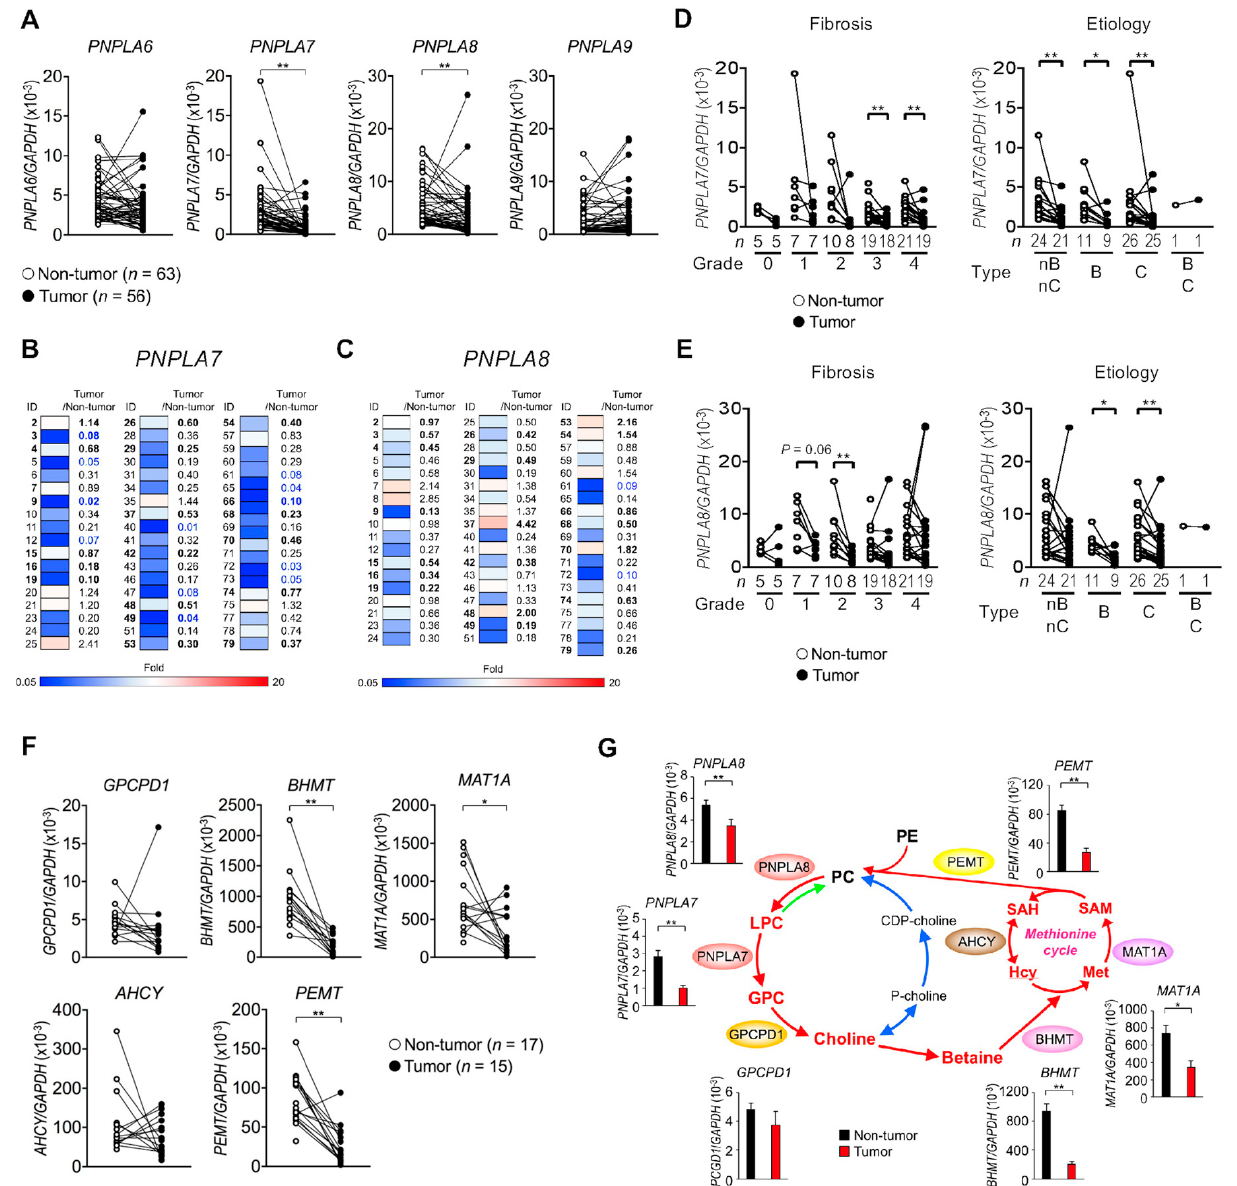
Figure 6. Reduced expression of PNPLA7 and PNPLA8 in human HCC. ( A ) qPCR analysis of PNPLA6, PNPLA7, PNPLA8, and PNPLA9 in tumor and non-tumor tissues from human HCC patients. The expression was normalized to GAPDH . ( B , C ) Heatmap representations of PNPLA7 ( B ) and PNPLA8 ( C ) expression in individual patients. Sample IDs and expression ratios (tumor versus non-tumor; values of <0.1 are highlighted in blue) are indicated. Patients with non-B/non-C type HCC are shown in bold. ( D , E ) Expression of PNPLA7 ( D ) and PNPLA8 ( E ) in human HCC differing in the stage of fibrosis and etiology. In terms of etiology, nB/nC (non-B and non-C), B, C and B/C indicate HCC unrelated to HBV and HCV infection (probably associated with NAFLD and NASH), that are due to HBV infection, HCV infection, and both HBV and HCV infection, respectively. ( F ) Expression of enzymes related to choline/methionine metabolism in tumor and non-tumor tissues from human HCC patients. ( G ) Expression levels of key enzymes in tumor and non-tumor tissues from human HCC patients are summarized on the metabolic map of PC catabolism and the methionine cycle. Mean ± SEM, * p <0.05 and ** p < 0.01 versus non-tumor tissue. All of the enrolled patients underwent liver resection for treatment of HCC. Gender, age, and disease stages of the patients are summarized in Table